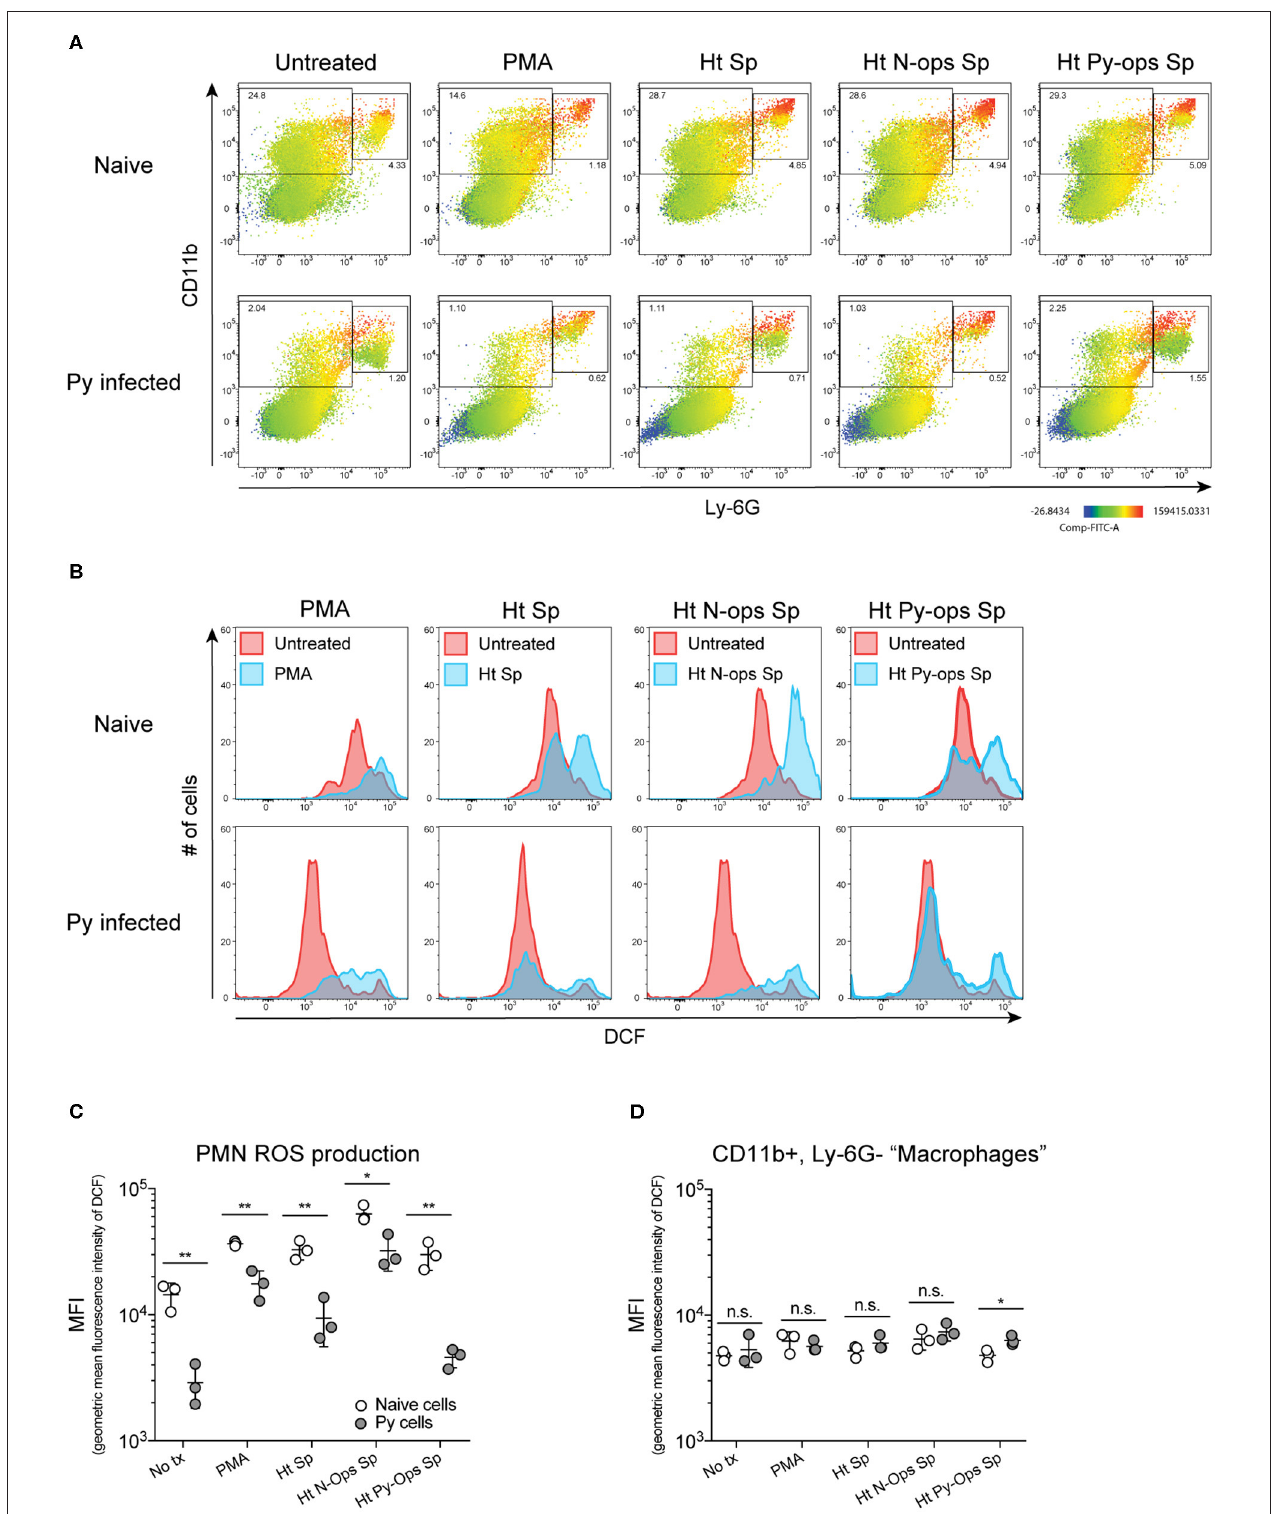
FIGURE 6 | Splenic PMNs from P. yoelii infected mice have defective ROS production in response to heat-killed Sp. C57BL/6N mice were infected with 10 5 Py pRBCs. Single cell suspensions from whole spleens of naïve and Py-infected mice (days 14 or 15 p.i.) were incubated with DFC to detect intracellular ROS. Cells were